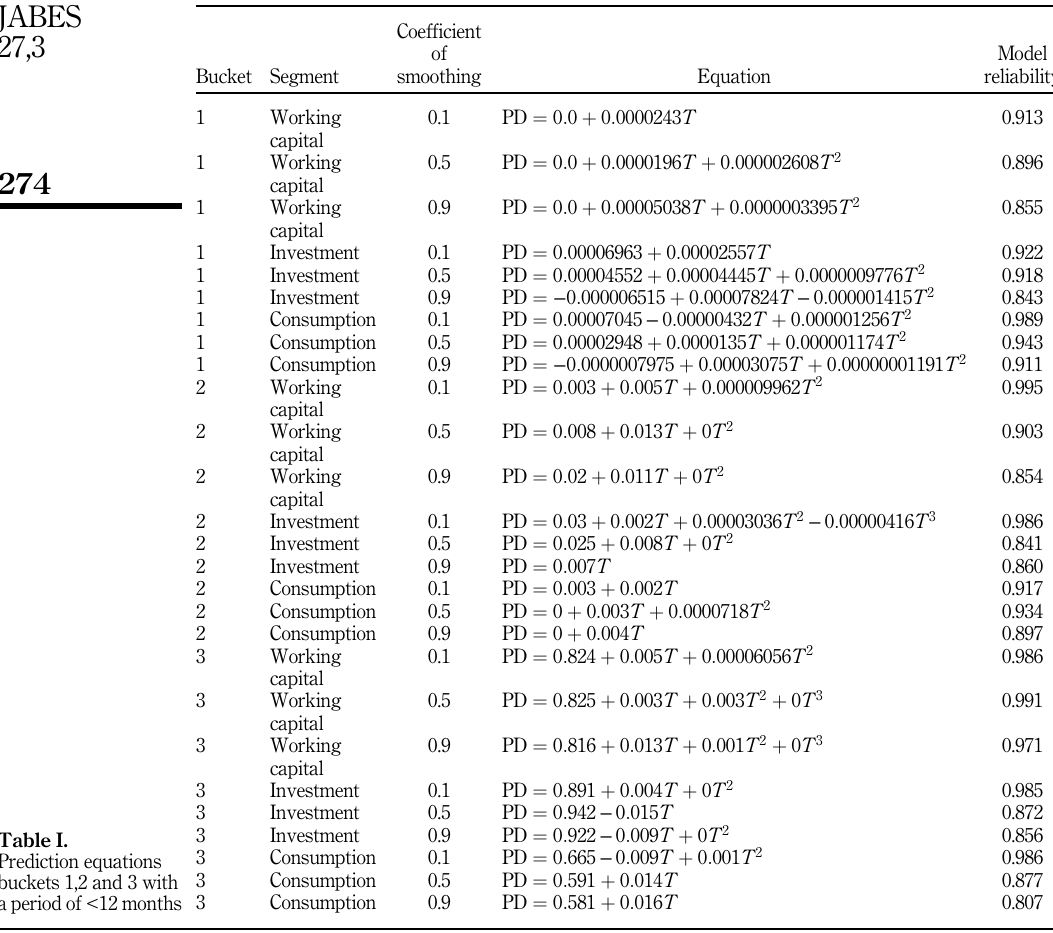
Table I. Prediction equations buckets 1,2 and 3 with a period of <12